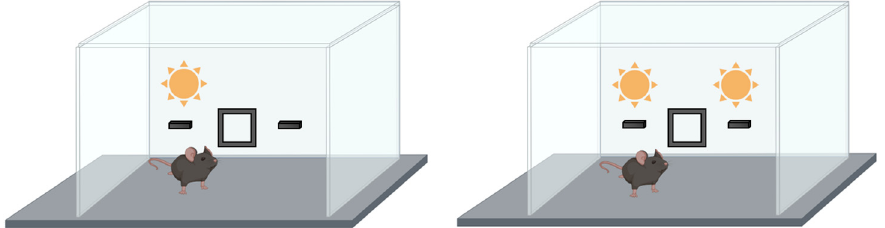
Figure 4. Go/no-go test. This test is performed in operant behavioral chambers where the animal receives go stimuli and must respond by pressing a lever, and will receive a reward, or no-go stimuli, for which it must withhold its response.